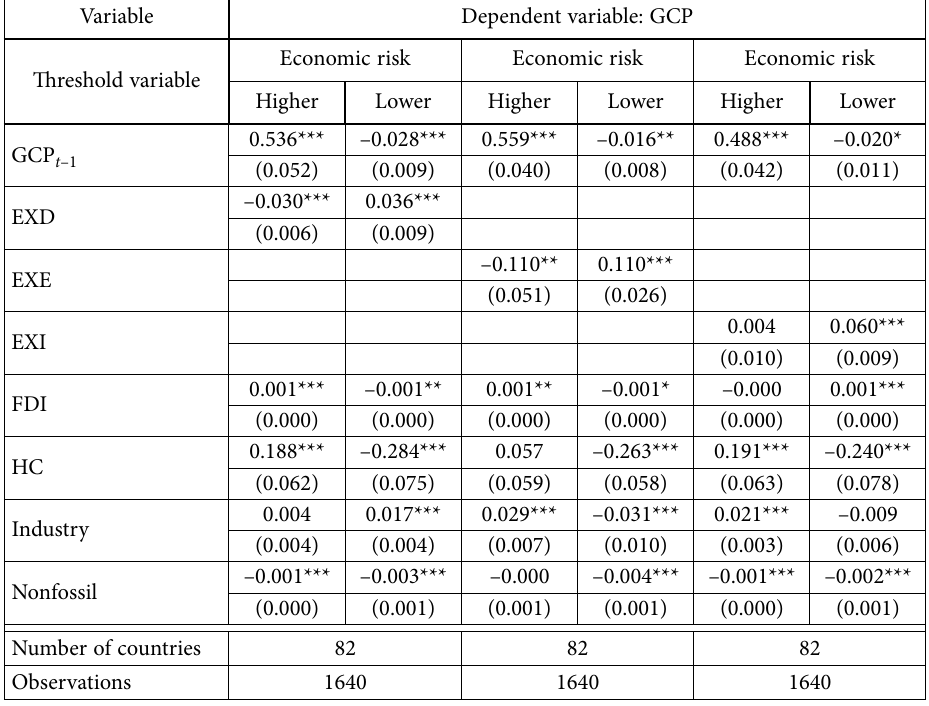
Table 7. DPT estimations for GCP (threshold = ER)